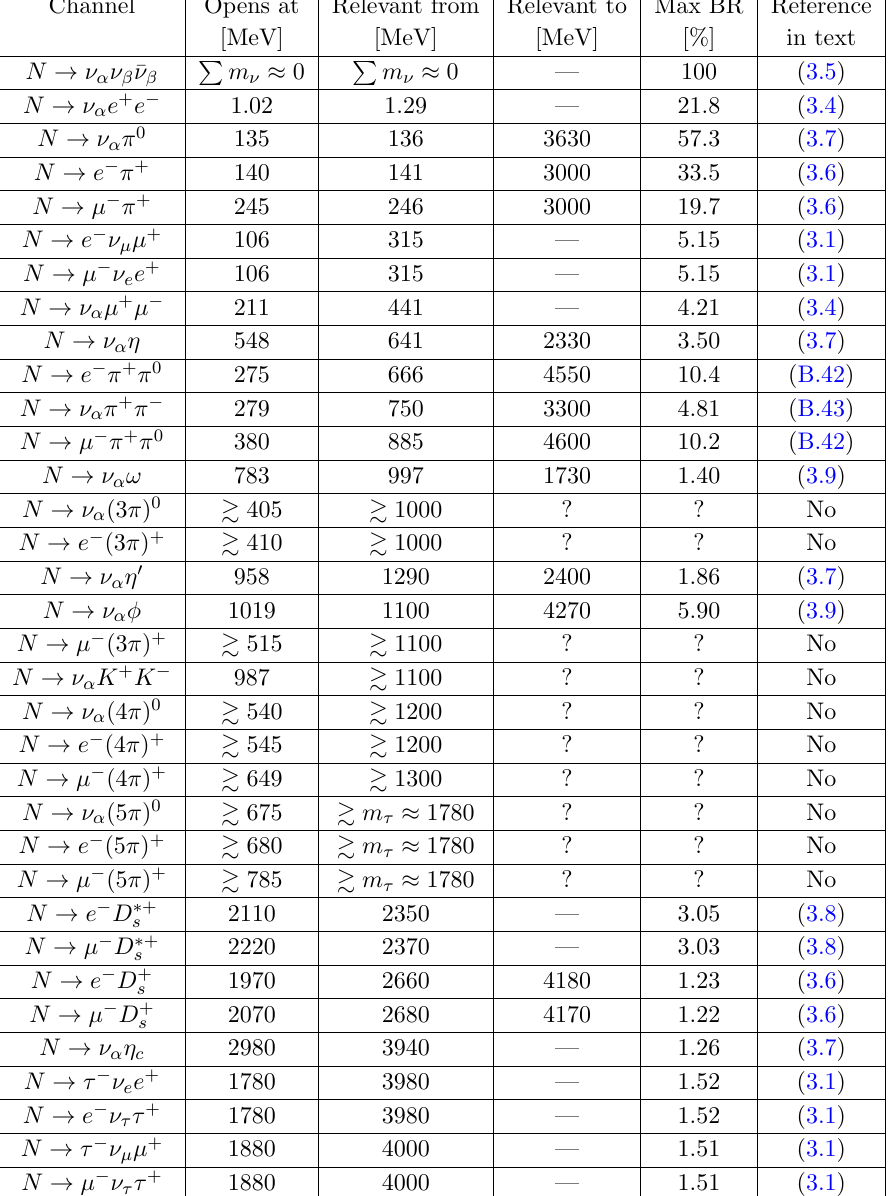
Table 5 . Relevant HNL decay channels. Only channels with the branching ratio above 1% covering the HNL mass range up to 5 GeV are shown. The numbers are provided for For neutral current channels (with (cid:23) a in the (cid:12)nal state) the sum over neutrino (cid:13)avors is taken, otherwise the lepton (cid:13)avor is shown explicitly. Columns : (1) the HNL decay channel. Notation ( n(cid:25) ) a means a system of n pions with the total charge a . (2) The HNL mass at which the channel opens; (3) The HNL mass starting from which the channel becomes relevant. For multimeson (cid:12)nal states we provide our \best-guess estimates"; (4) HNL mass above which the channel contributes less than 1%; \|" means that the channel is still relevant at M N = 5 GeV, \?" means that we could not estimate the relevance of the channel; (5) The maximal branching ratio of the channel for M N < 5 GeV; (6) Reference to the formula for the decay width of the channel, if present in the text.